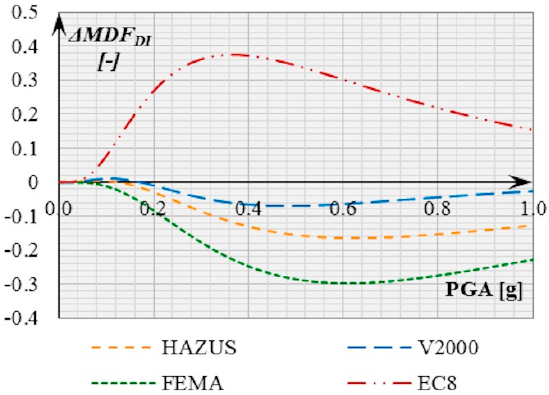
Figure 27. Differences between vulnerability curves calculated using other methods and the ones calculated using the modified DI method. calculated using the modified DI method.